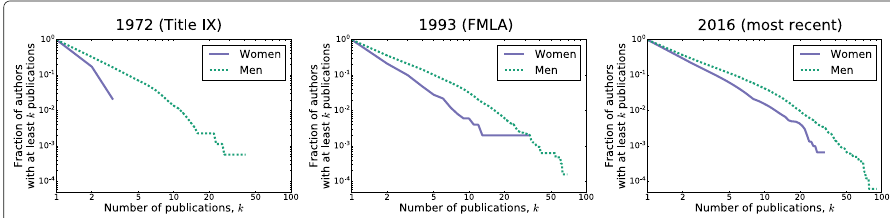
Fig. 2 Evolution of the cumulative degree distributions in the INFORMS network suggests that women are disproportionately underrepresented among authors with many publications. Plots display the normalized cumulative author degree distribution for the indicated year, i.e., the vertical axis is the fraction of authors of this gender with at least that number of publications. Since there are more men than women in the network, the degree distribution for men is expected to extend to more publications than that for women. However, the steeper slope of the distribution for women (in log scale) suggests their systematic underrepresentation, especially in the high-publication tail of the distribution (quantified in Fig. 3). See Additional file 1 for a video of the cumulative degree distributions over time